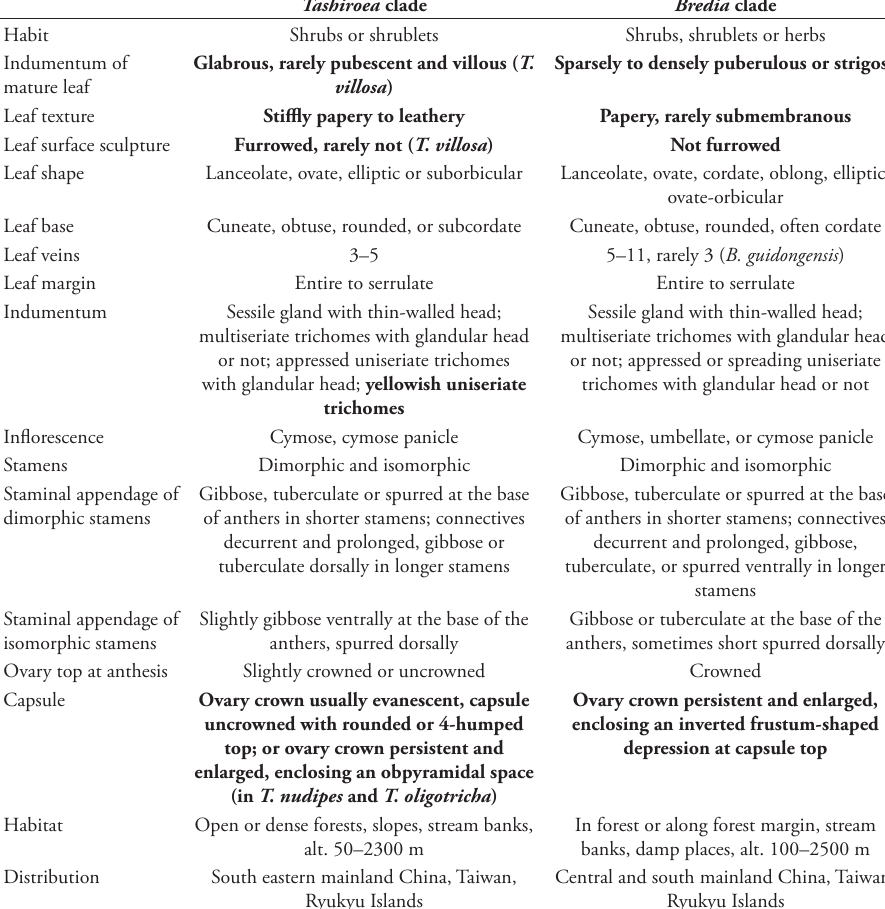
Table 1. Comparison of the Tashiroea clade and the Bredia clade. Potential diagnostic characteristics are indicted in bold. Tashiroea clade Bredia clade Shrubs or shrublets Shrubs, shrublets or